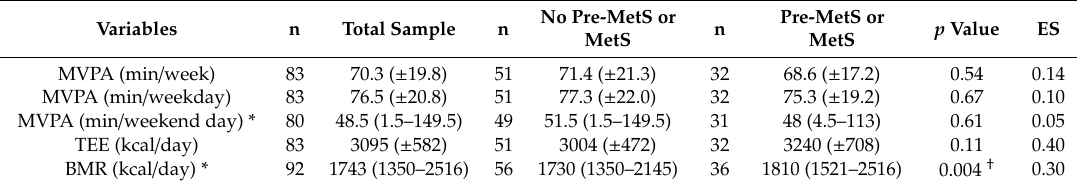
Table 2. Description of physical activity variables within physical and energy expenditure.